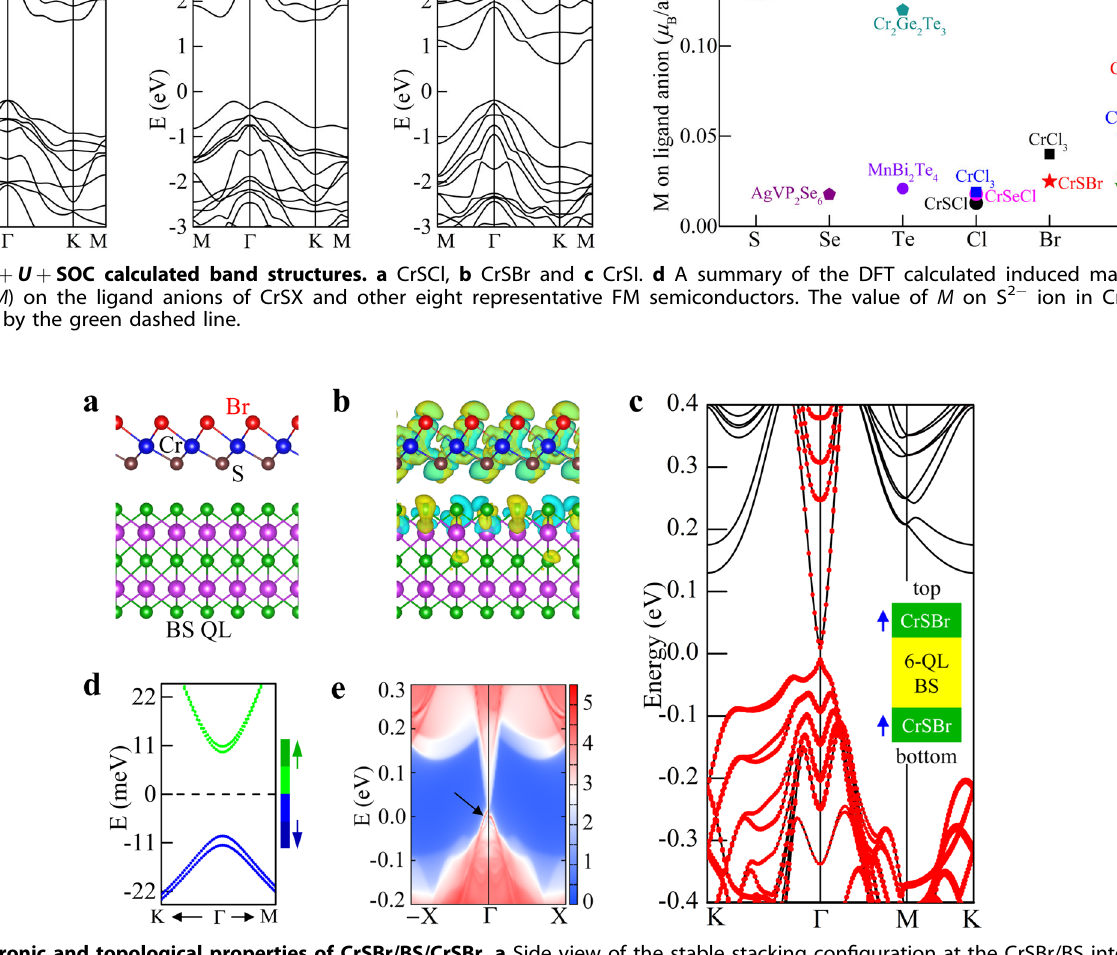
Fig. 3 Electronic and topological properties of CrSBr/BS/CrSBr. a Side view of the stable stacking con fi guration at the CrSBr/BS interface. b The spin polarization at the CrSBr/BS interface. Spin-up and spin-down densities are indicated by the yellow and cyan isosurfaces, respectively. The isovalue surface level of spin density is 6 × 10 − 6 e Å − 3 . c DFT + U + SOC calculated band structure. The inset shows the sketch of the magnetizations (represented by blue arrows) of CrSBr MLs. d The four bands near the Fermi level. e The band structure and the chiral edge state (highlighted by the black arrow) of the one-dimensional CrSBr/BS/CrSBr